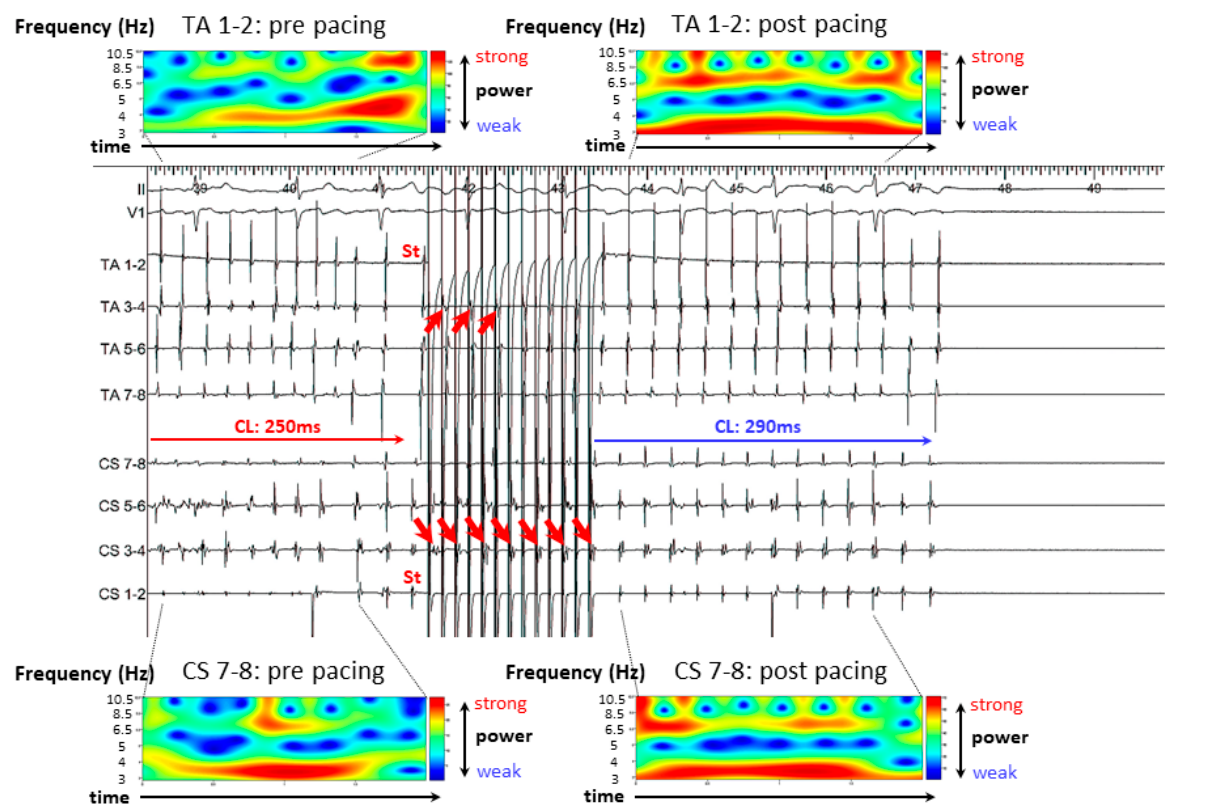
Figure 3. Case 2. AF was terminated by simultaneous biatrial high-rate straight pacing from CS and HRA. Pacing captured the CS or HRA on alternately beats (red arrows), and AF organized into a more stable tachycardia. In the continuous wavelet transform analysis, red lines prolonged after pacing. The most powerful pseudo frequency (= mean dominant frequency) is colored red. AF = atrial fibrillation; CL = cycle length; CS = coronary sinus; HRA = high right atrium; PAF = paroxysmal AF; St = stimulation; TA = tricuspid annulus.